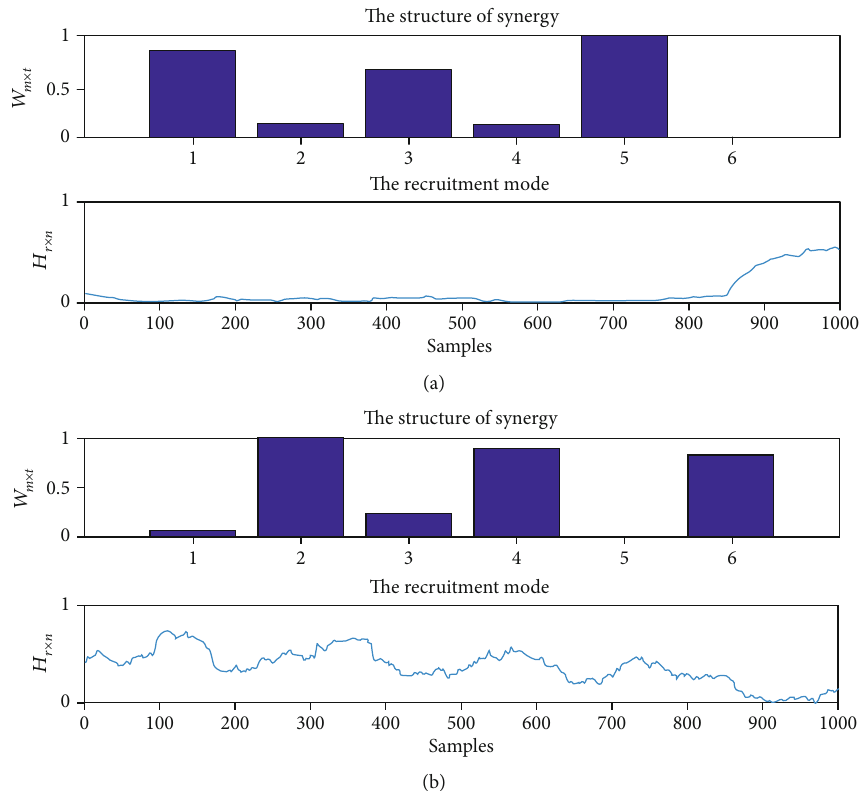
Figure 7: The typical results of muscle synergies of upper limbs for stroke patients during the HRI with counterclockwise circle-drawing movements. (a) The synergy pattern and activation coe ffi cients for the fi rst synergy; (b) the synergy pattern and activation coe ffi cients for the second synergy. The structure of synergy represents the synergy pattern of muscle synergies, and the recruitment mode represents the activation coe ffi cients of muscle